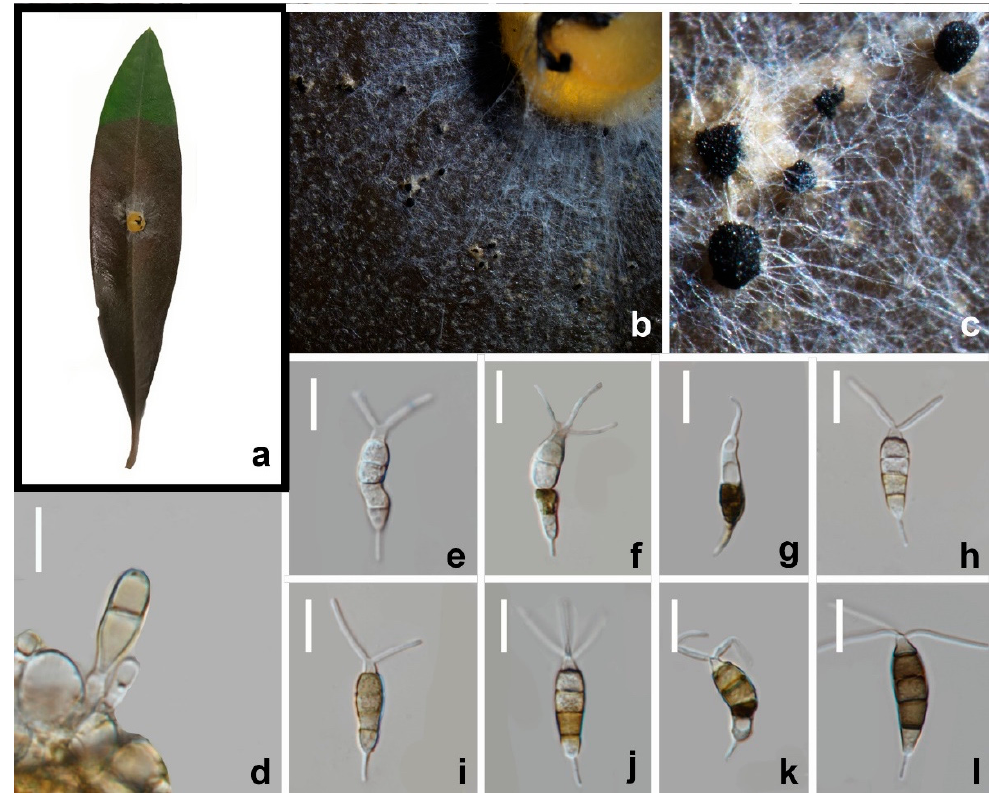
Figure 9. Neopestalotiopsis terricola (HKAS 123213) ( a ). Olea europaea leaves infected by N. terricola ( b , c ) Conidiomata on infected leaves. ( d ) Conidiogenous cells and conidia. ( e – l ) Conidia. Scale bars: ( d – l ) = 10 μ m.